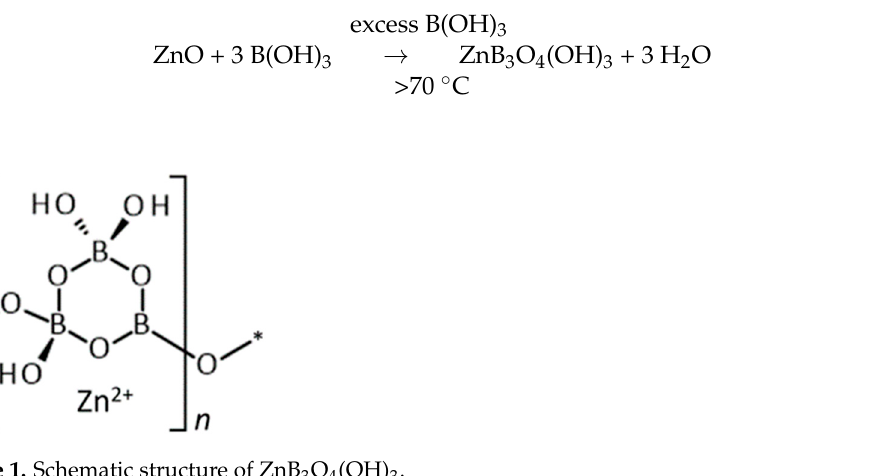
Figure 1. Schematic structure of ZnB 3 O 4 (OH) 3 .